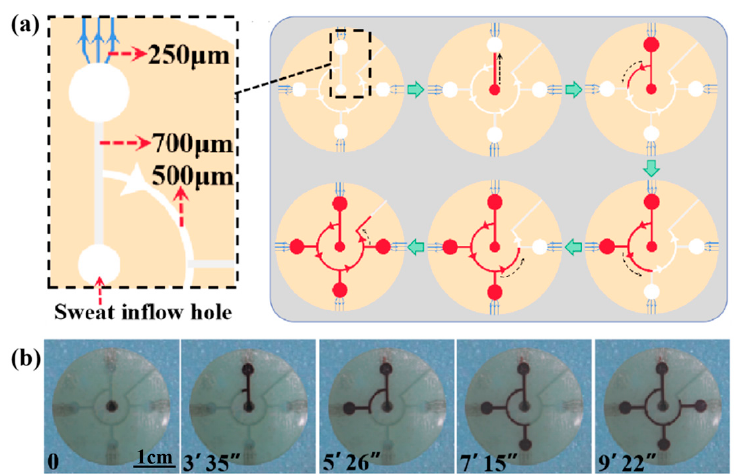
Figure 7. ( a ) A schematic diagram of the entire platform for chronological collection of liquid. ( b ) The time took for the liquid to fill each